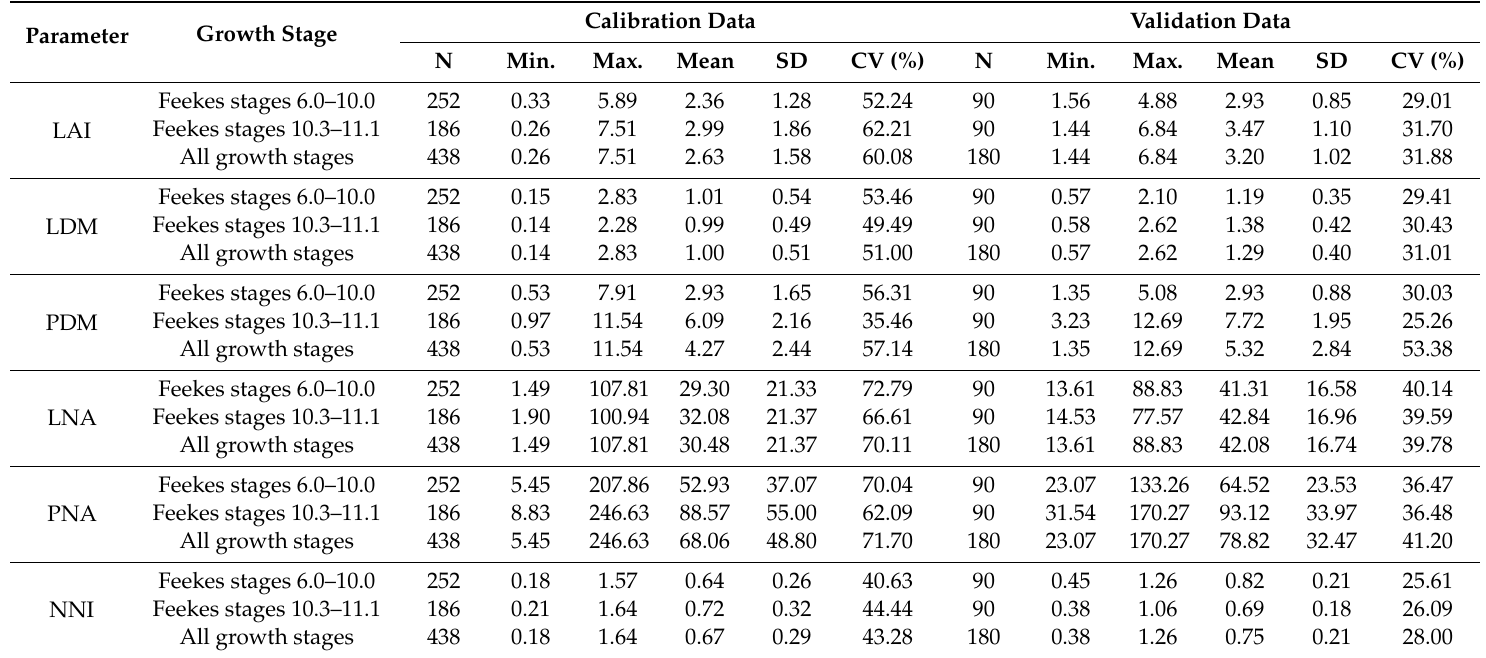
Table 3. Descriptive statistics of winter wheat leaf area index (LAI), leaf dry matter (LDM), plant dry matter (PDM), leaf nitrogen accumulation (LNA), plant N accumulation (PNA) and nitrogen nutrition index (NNI) across varieties, sites (Sihong, Rugao, and Xinghua) and years